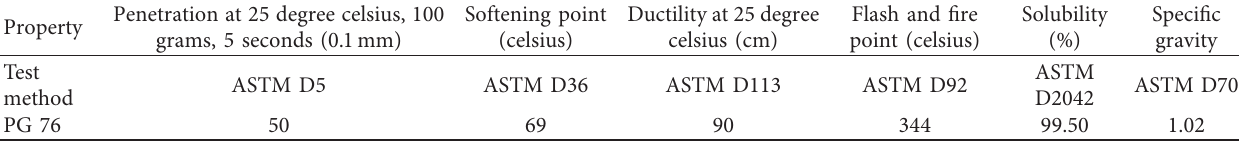
Table 1: Properties of binder PG-76.